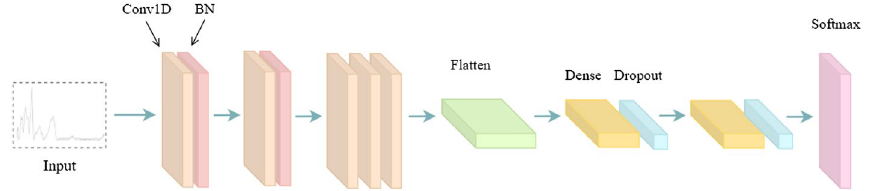
Figure 5. Improved AlexNet model structure.